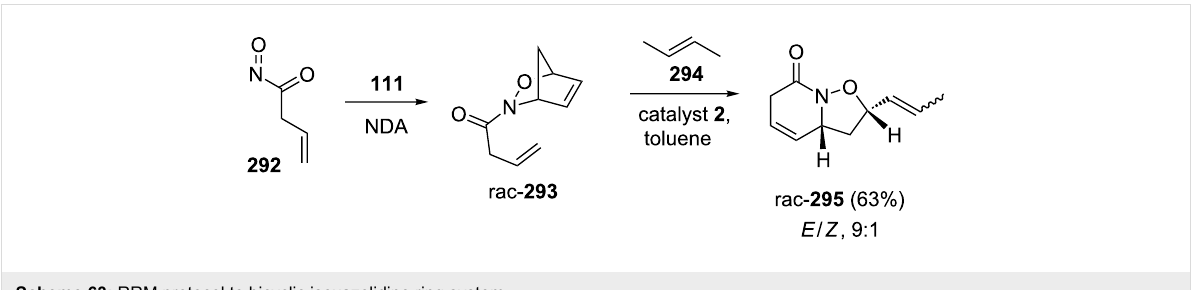
Scheme 63: RRM protocol to bicyclic isoxazolidine ring system.